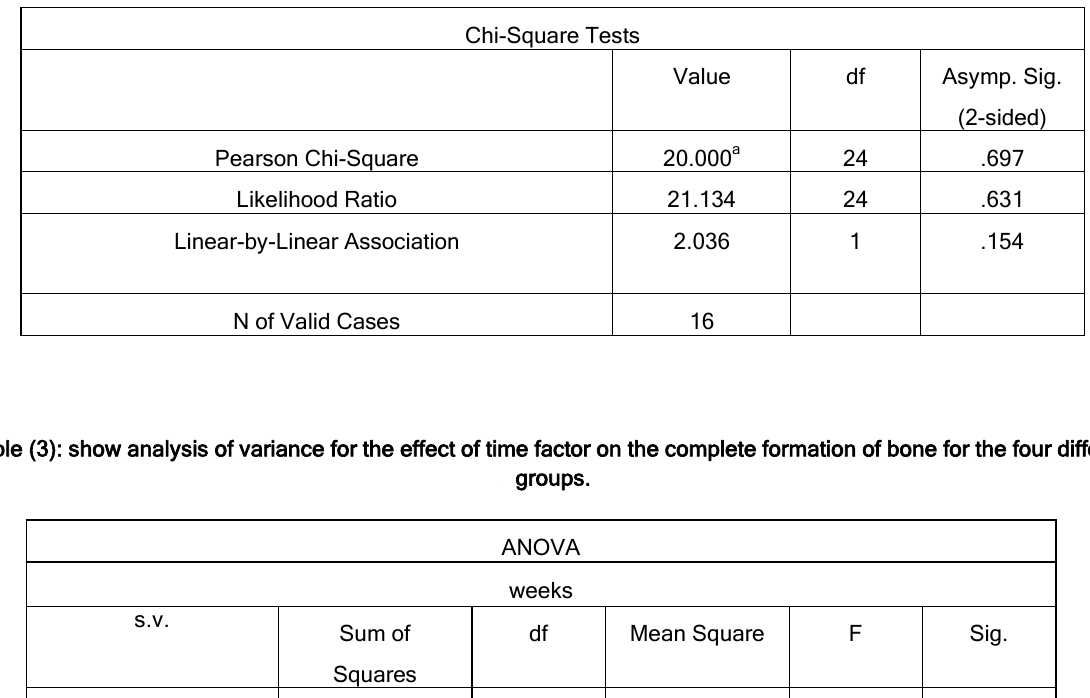
Table ( 2 ):Chi- square test show that there is statistical significant differences between the four different groups.